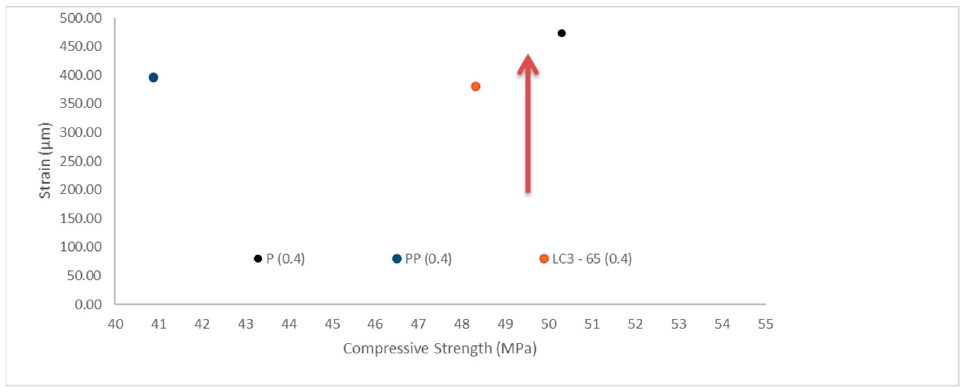
Figure 11. Strength vs. strain.